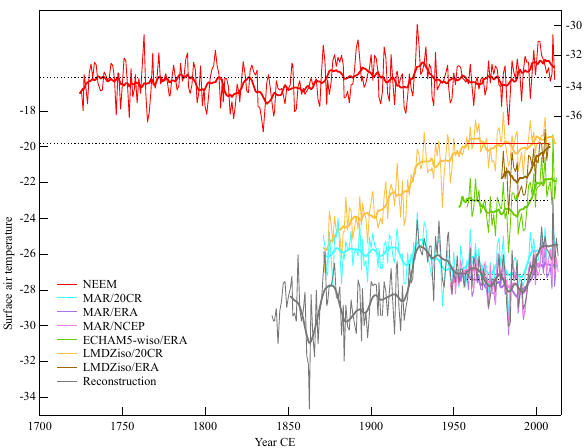
Figure 11. Comparison of NEEM δ 18 O (red, in ‰) with gridded temperature reconstructions and simulations (in ◦